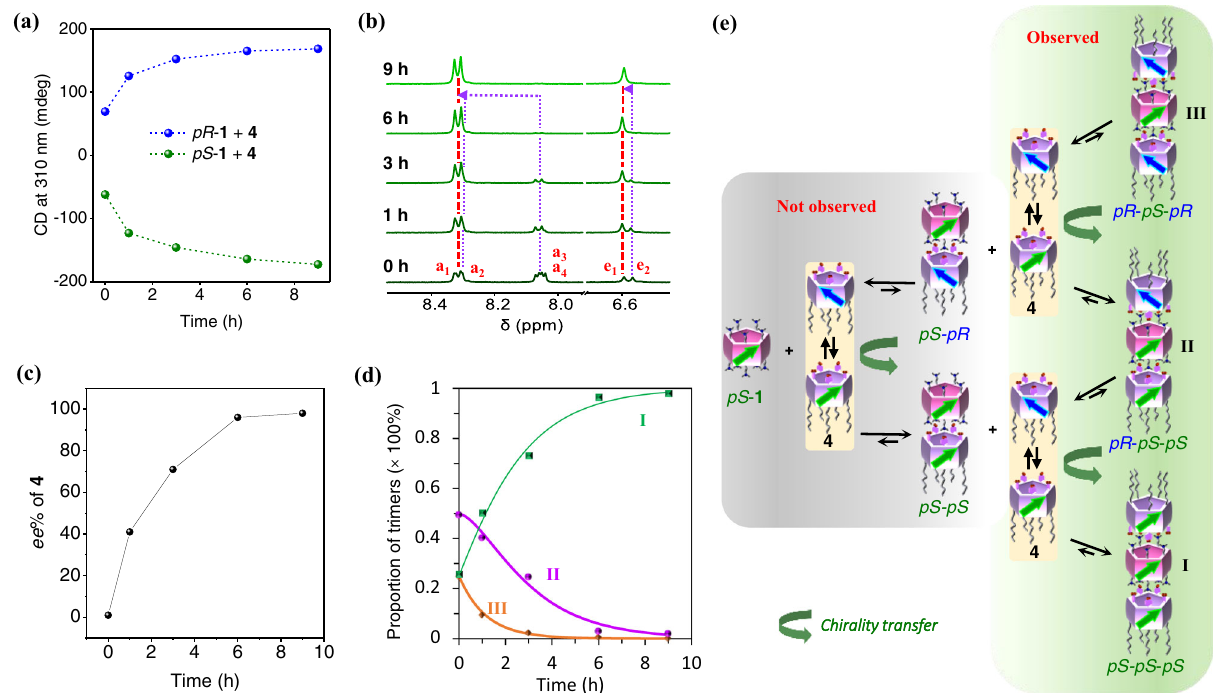
Fig.4|Chiralitytransferfromenantiomeric 1 to 4 uponheating.a CDintensities at 310nm of mixtures of pR - 1 or pS - 1 with 4 upon heating at 50°C. The con- centrationsof 1 and 4 were0.05and0.1mM,respectively. b Partial 1 HNMRspectra (400MHz, CDCl 3 ) of a mixture of pS - 1 and 4 upon heating at 50°C. The